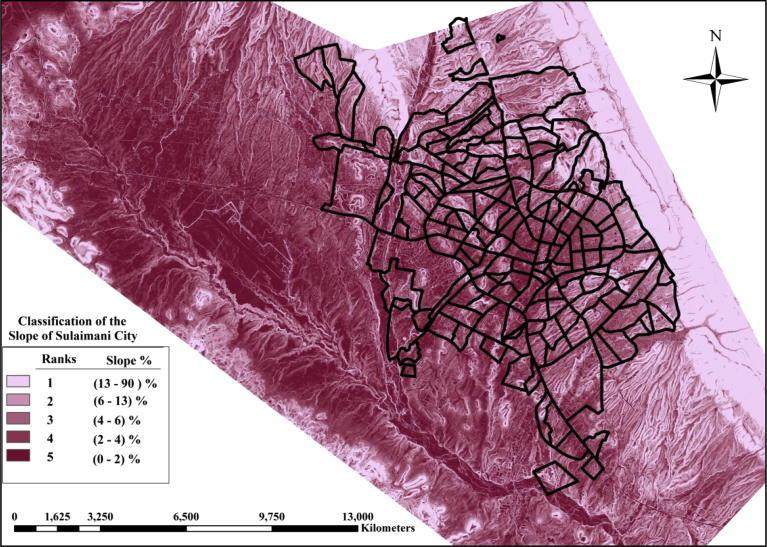
Classification of the slope of the study area.